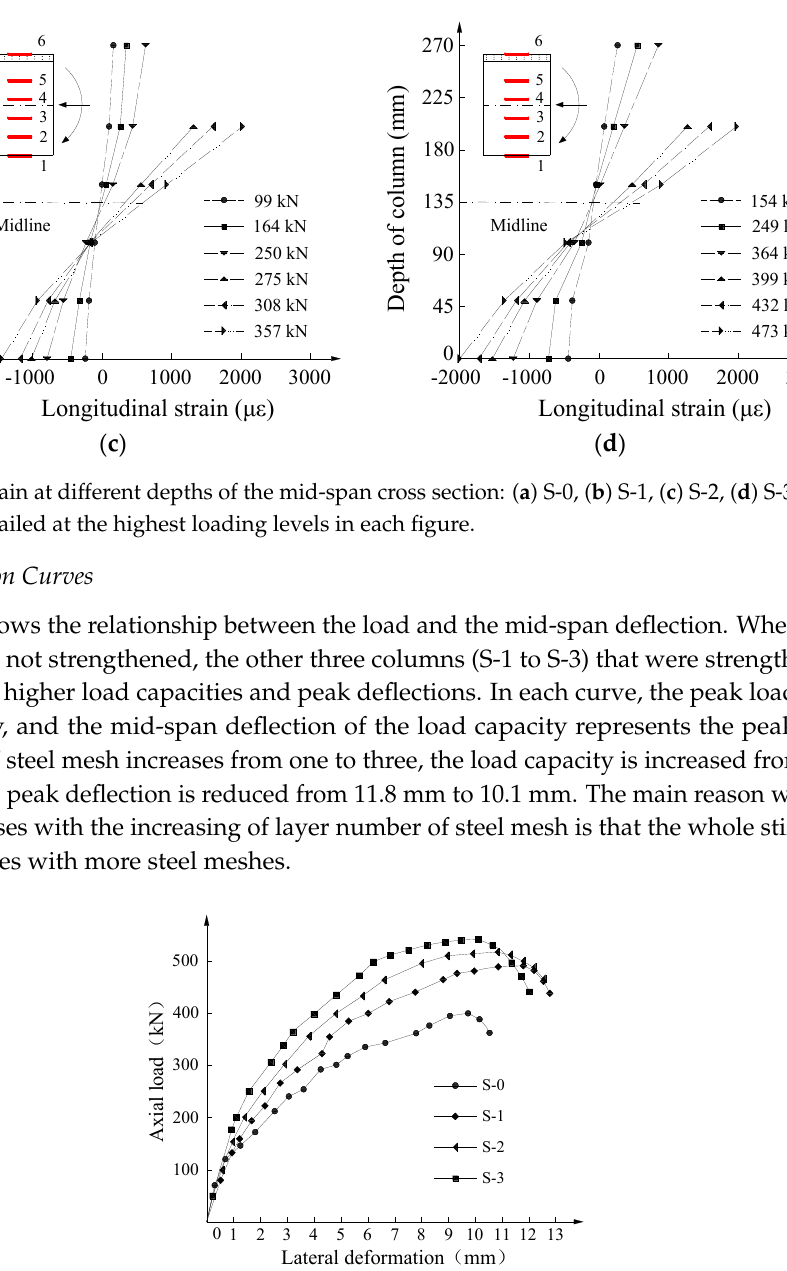
Figure 13. Test result of load-deflection curves.